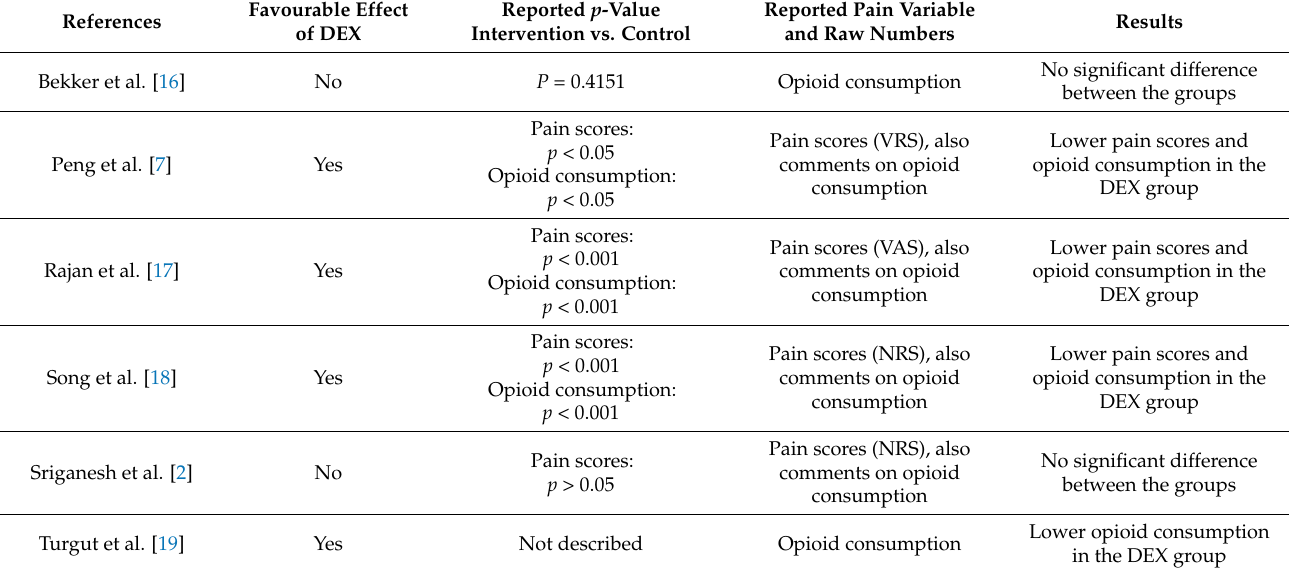
Table 2. Overview of the reported effects of DEX on postoperative pain in the included trials (DEX group(s) compared to the control